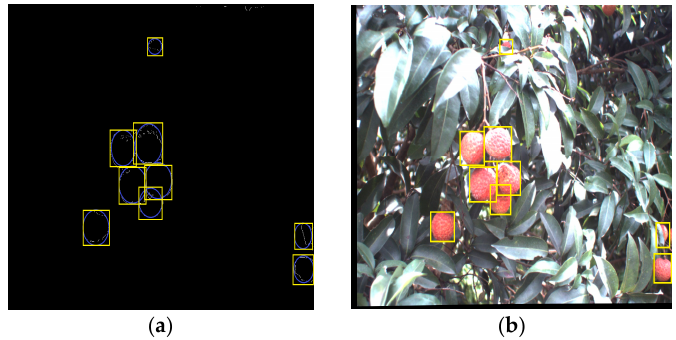
Figure 8. Final recognition of mature litchi fruits. ( a ) Final label extraction combining the label extractions based on the four kinds of classifiers; ( b ) Final recognition of mature litchi fruit based on the label.